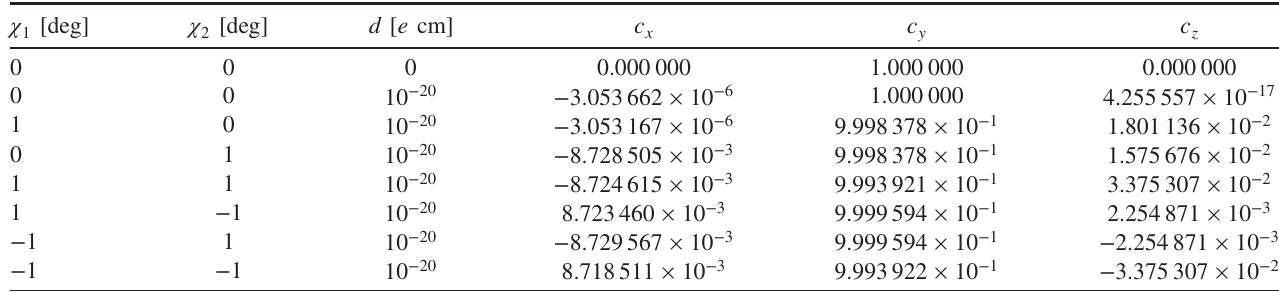
TABLE V. Components of the spin closed orbit vector ⃗ c ¼ ð c S 2 in the machine (see Fig.